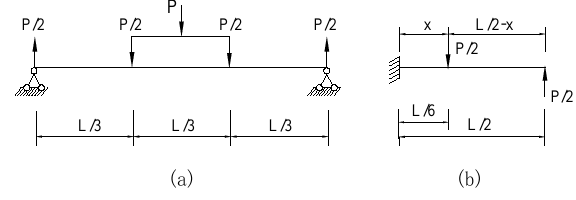
Figure 4: Force Analysis Diagram of